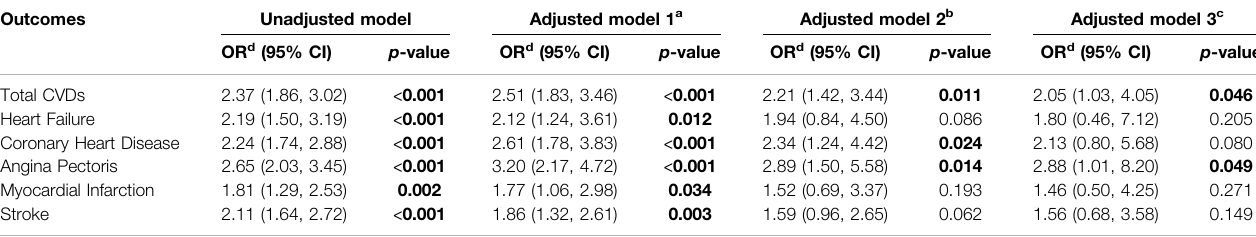
TABLE 2 | Univariate and multivariate logistics regression model of sTfR for CVDs.